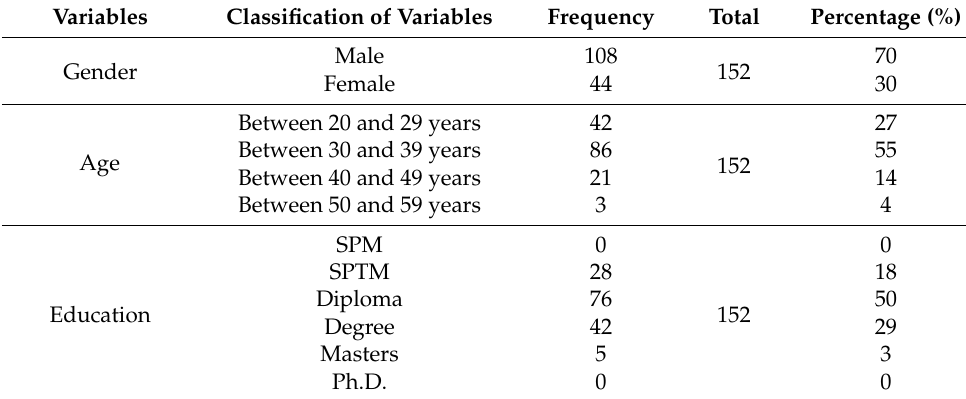
Table 2. Demographics of